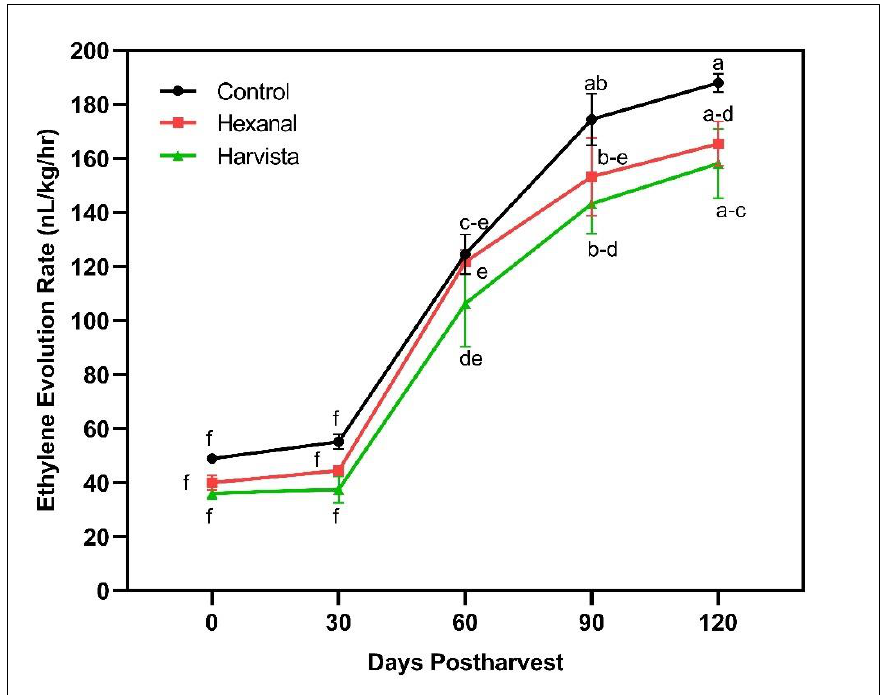
Figure 1. Effects of preharvest sprays hexanal and Harvista TM on ethylene in ‘Honeycrisp’ apple throughout 120 days postharvest. Each value represents the least-squares means ± SE of eight fruit. LS-means with the same letter are not significantly different when comparing treatments with days postharvest based on the Tukey- Kramer test at α = 0.05.